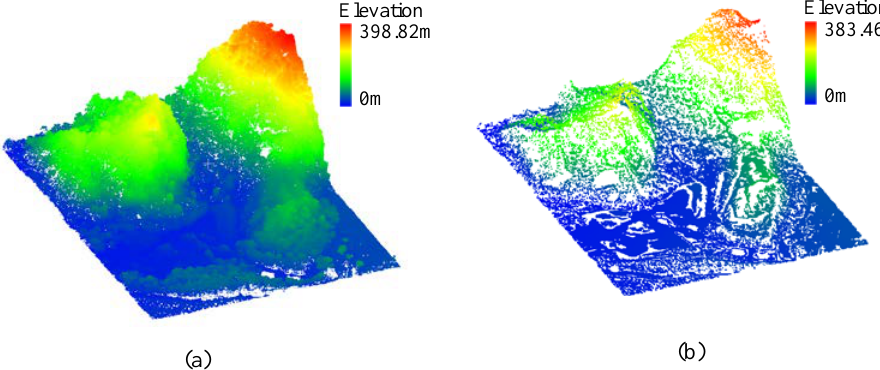
Figure 7. Selection result of ground seed points. ( a ) Original point cloud, ( b ) ground seed points.